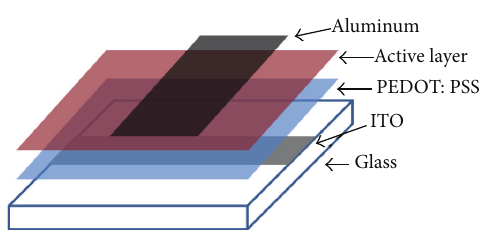
Figure 1: Structure of organic solar cell device with heterojunction active layer structure of PCDTBT: PC 71 BM and buffer layer of PEDOT: PSS.